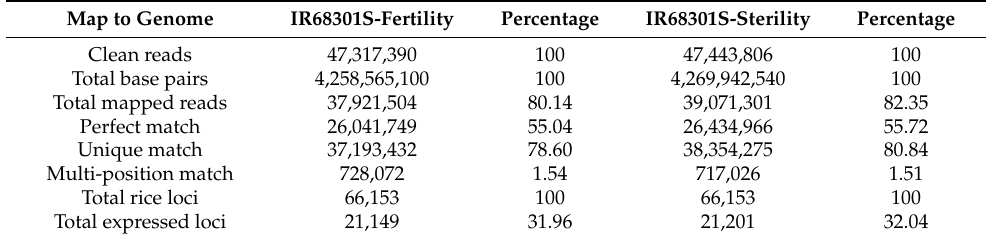
Table 2. Summary of sequencing data quality and the statistics of the transcriptome assembly. Map to